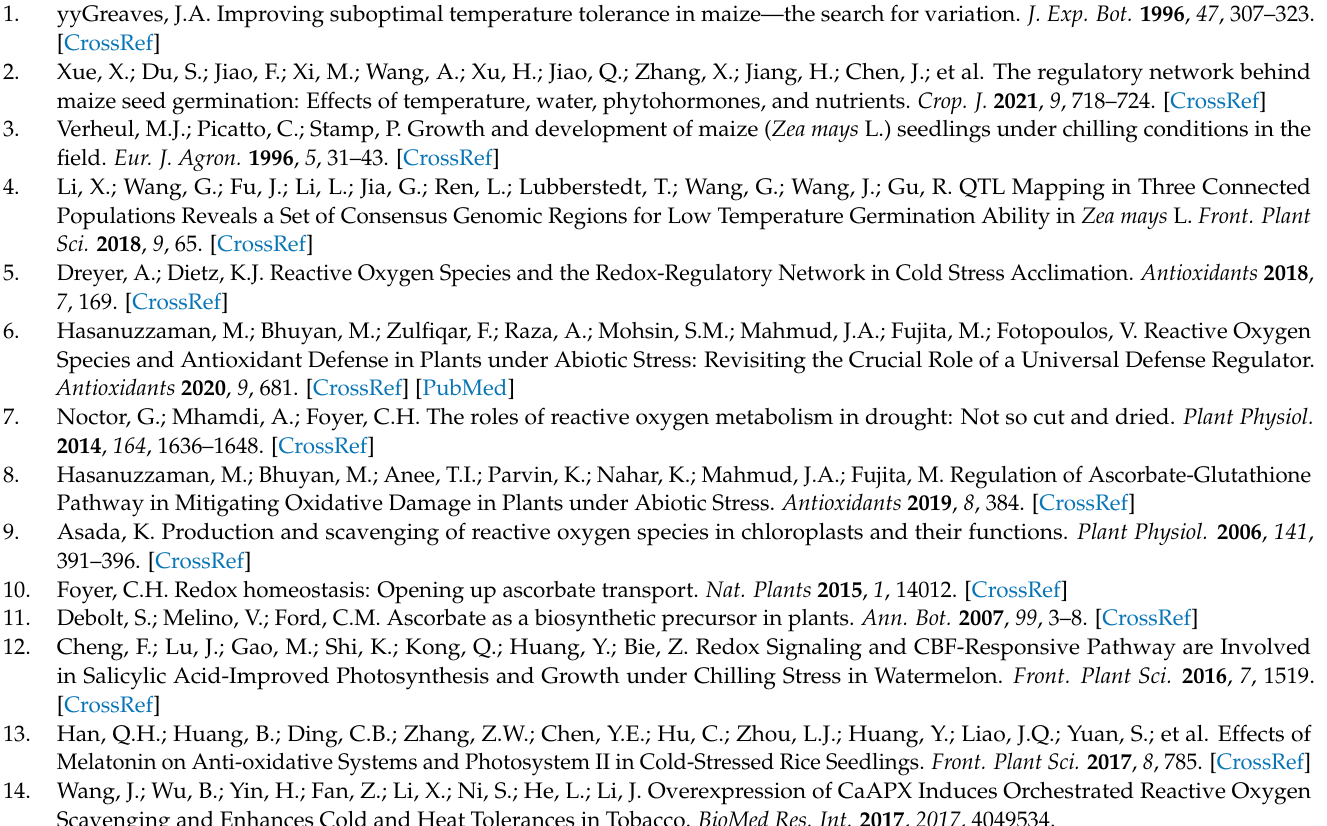
and JingX201, Figure S2: Transcription profile of key components in antioxidative system, Figure S3: Physiological analysis of maize inbred at mature stage. Table S1: Daily temperature during germi- native experiment, Table S2: The primer sequences used for qRT-PCR assays, Table S3: two-way ANOVA analysis